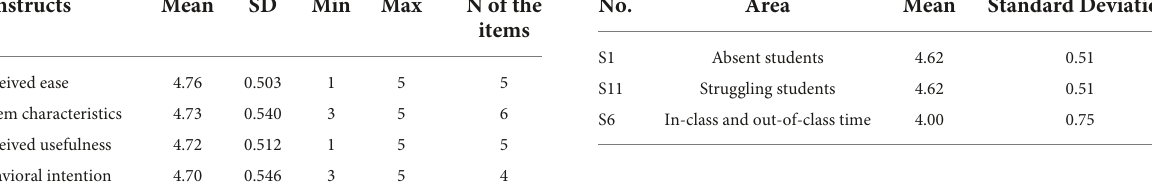
TABLE 6 Teachers’ perceptions associated with instructional considerations in the FL.